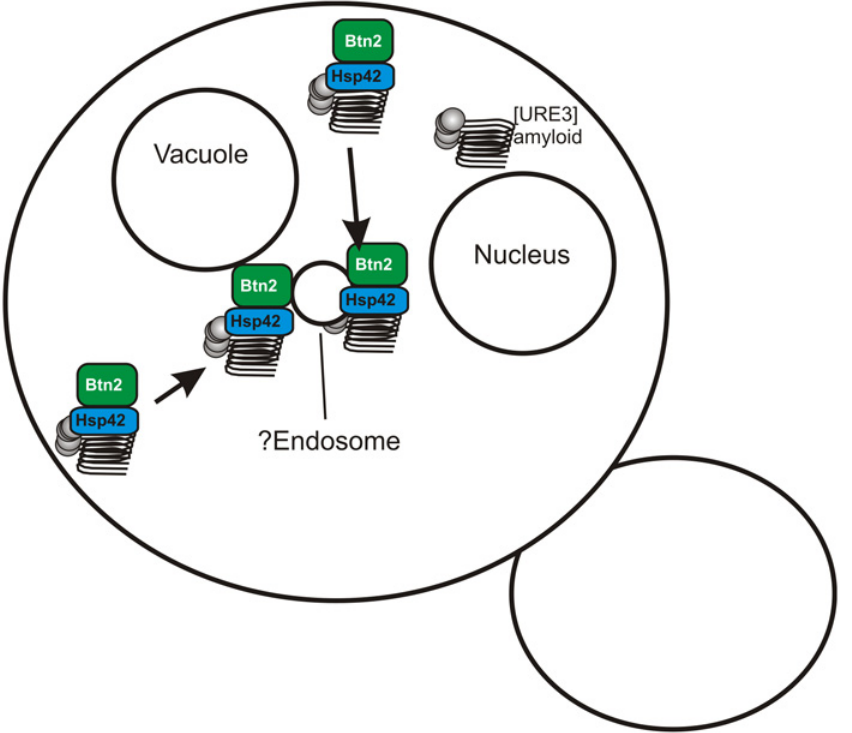
Fig 2. Btn2p sequesters prion amyloid filaments, curing the prion. Btn2p gathers filaments of Ure2p amyloid (the [URE3] prion) to a single site in the cell, possibly the endosome. If the prion has a low seed number then even the normal levels of Btn2p are sufficient to sequester nearly all of the seeds, so that daughter cells without seeds, and therefore cured of the prion, are often